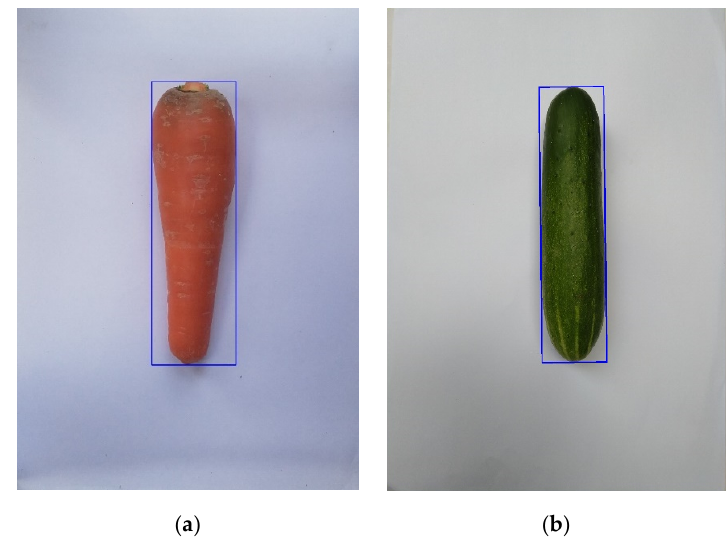
Figure 10. Bounding box (blue rectangle) in: ( a ) a carrot and ( b ) a cucumber.